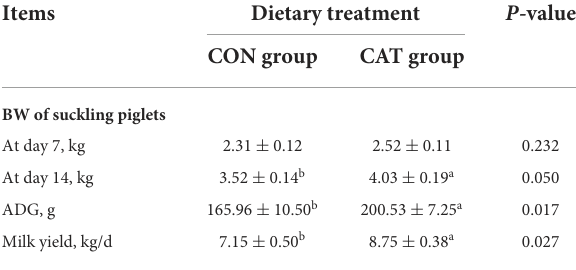
TABLE 3 The effects of maternal dietary CAT supplementation on growth performance of suckling piglets and milk yield of the sow. Items Dietary treatment P -value